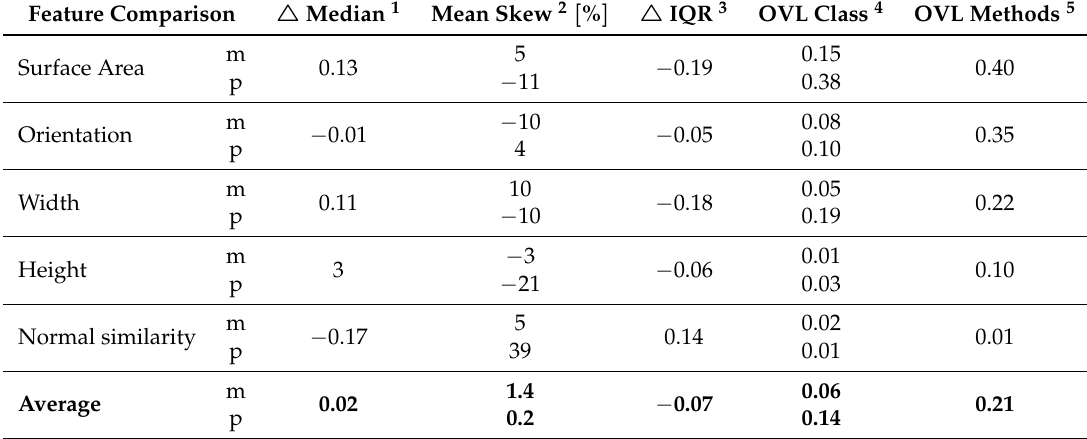
Table 7. Table with the boxplot statistics of the feature extraction from the segments of the point-based and the mesh-based method. Notes: 1 The difference between medians measure for data associativity, 2 The average skew is a measure for the symmetry of the feature values, 3 The average IQR per method is a measure for the data dispersion between both methods, 4 the difference in OVL over all the classes for each method is a measure for difference in the feature discrimitiveness, 5 the difference in OVL per class between both methods is a measure for the feature value similarity.